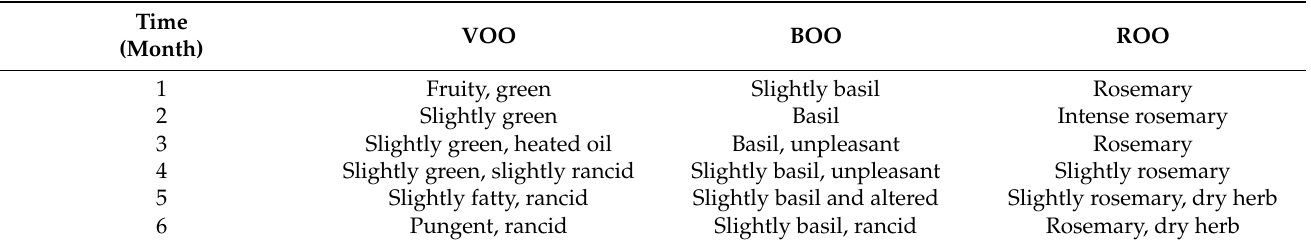
Table 6. Qualitative sensory evaluation of the aroma of VOO and flavored (BOO, ROO) samples during the storage